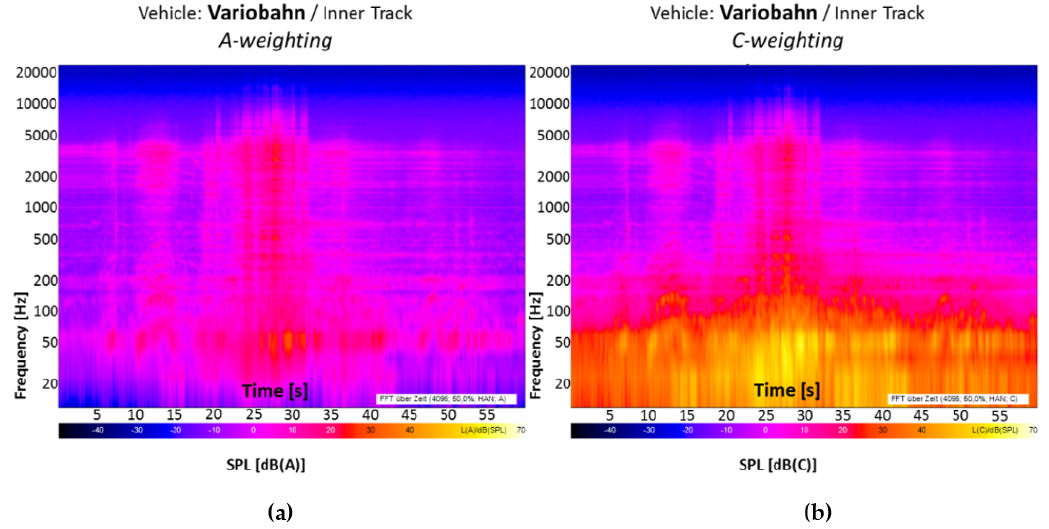
Figure 8. Pass-by sound pressure level of the same “new tram (type Variobahn)” calculated by Fast Fourier transform algorithm: ( a ) A-weighted signal; and ( b ) C-weighted signal.